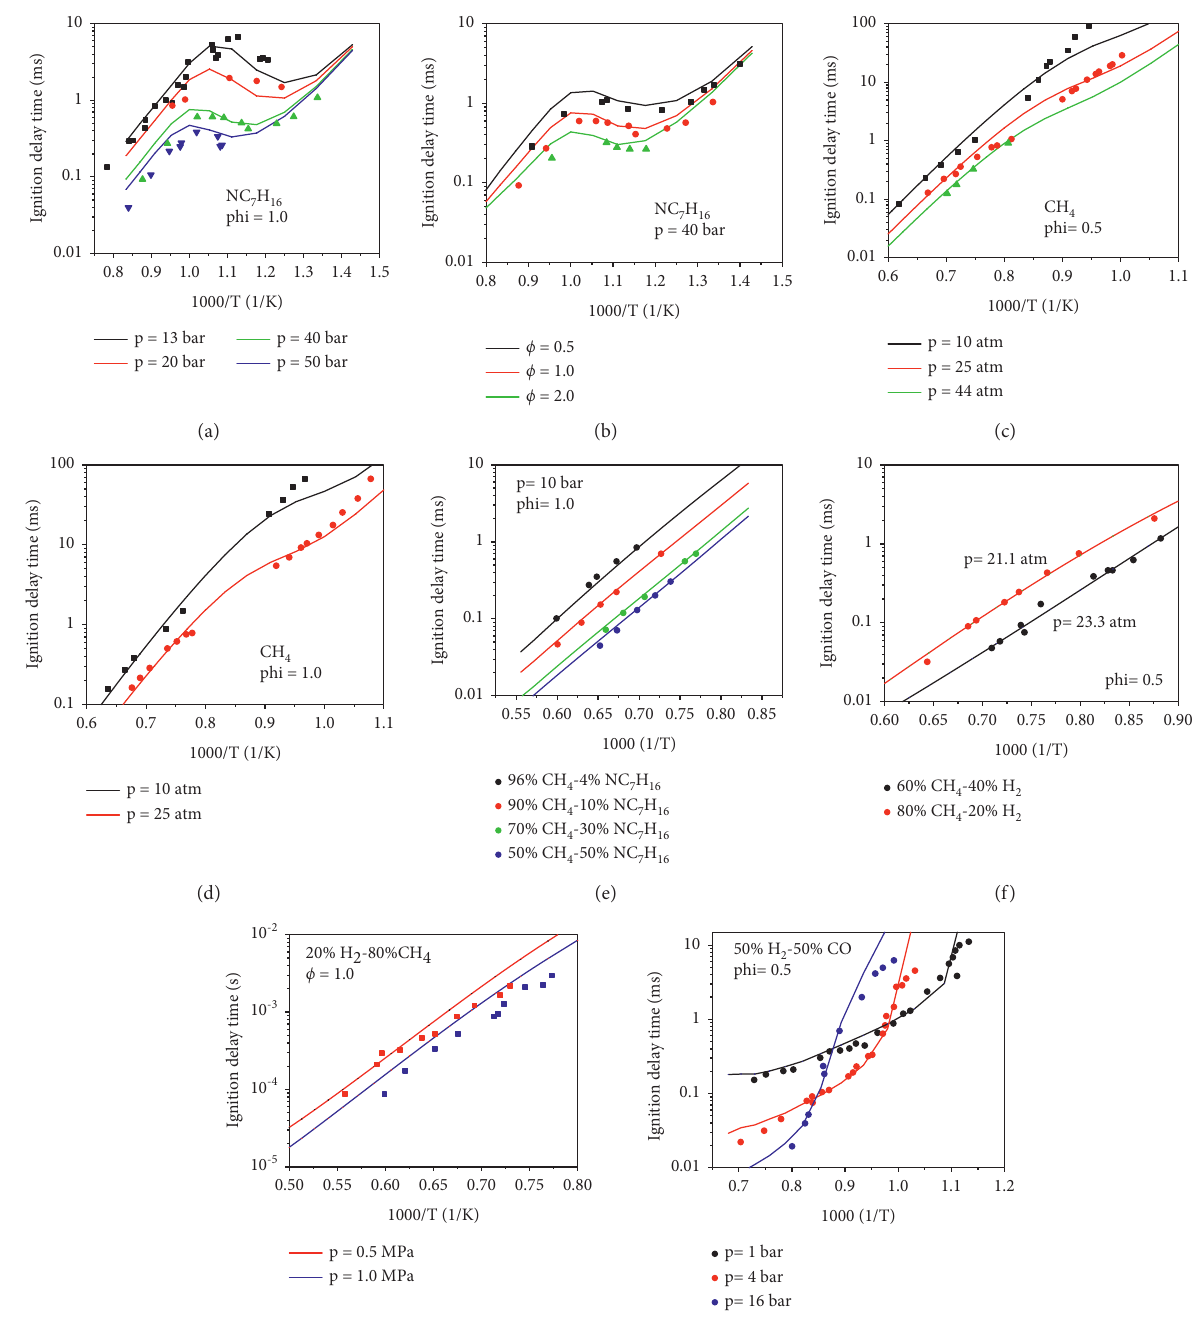
Figure 1: Ignition delay time validation for multiple conditions of n-heptane [34], methane [35], methane/n-heptane [36], methane/H [37, 38], and H 2 /CO [39]. Solid line: simulation; symbols: